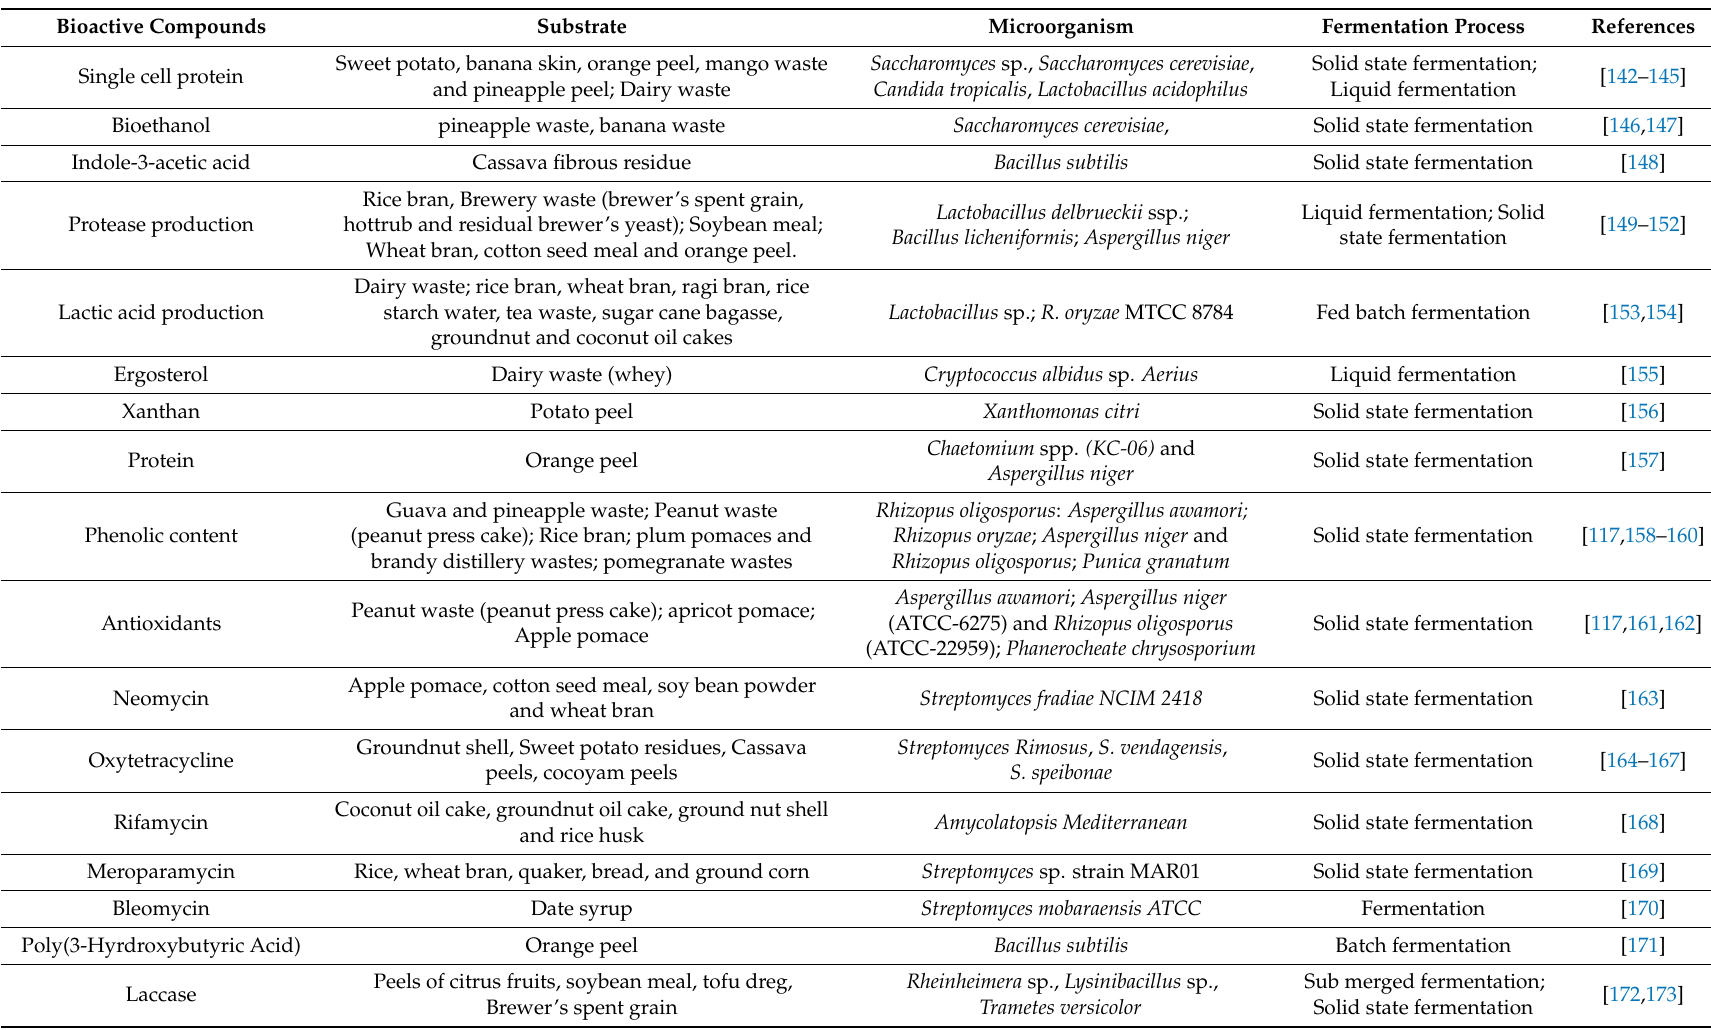
Table 2. Various bioactive compounds produced from different microorganisms by fermentation using diverse food processing